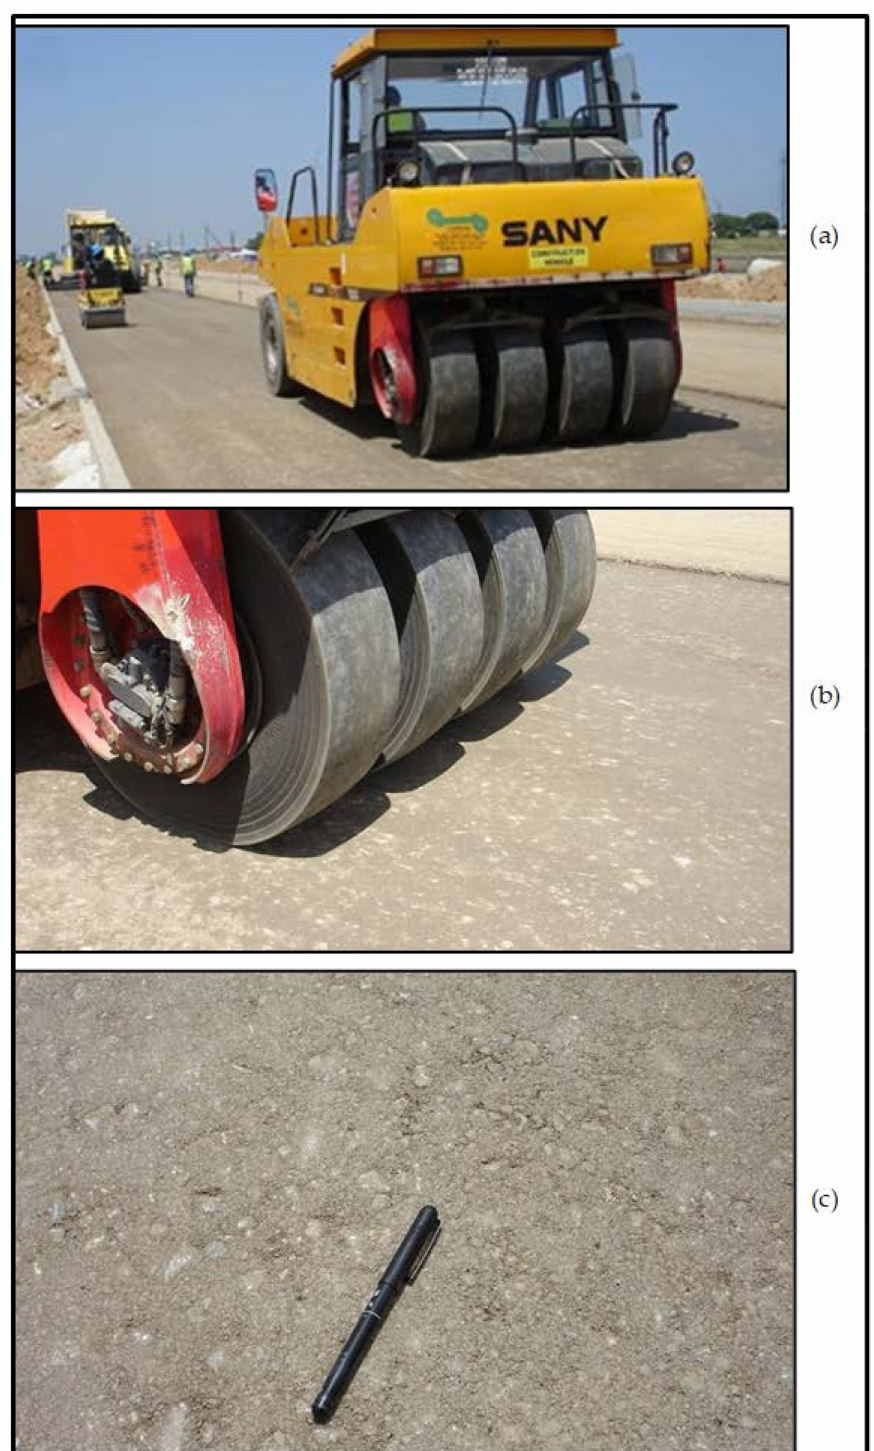
Figure 8. ( a ) Compaction of base-layer behind paver. ( b ) Final compaction with pneumatic roller to a high level of tolerance. ( c ) Achieved base texture with G5/G6 material with 1.2% anionic NME stabilising agent (0.7% residual